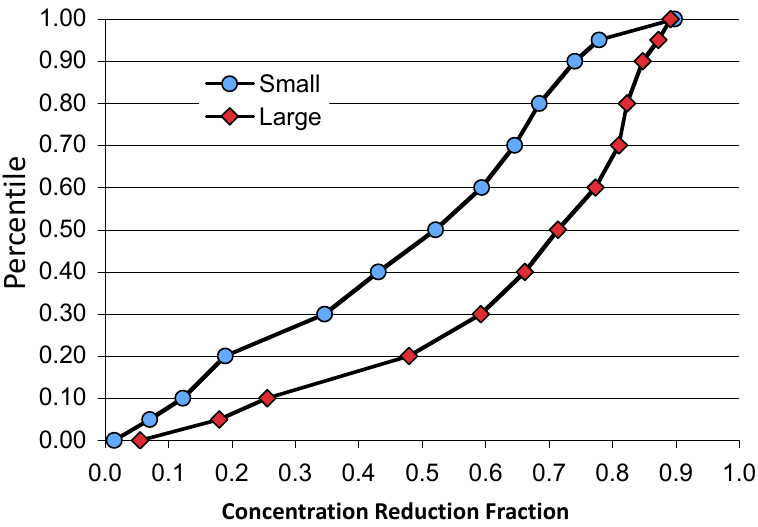
Figure 1. Distributions of P concentration reductions for large ( N = 43) and small ( N = 87) constructed wetlands.